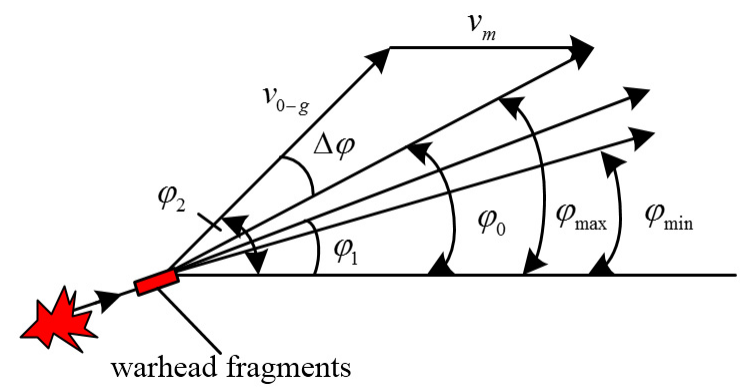
Figure 2. Schematic diagram of warhead fragment divergence.